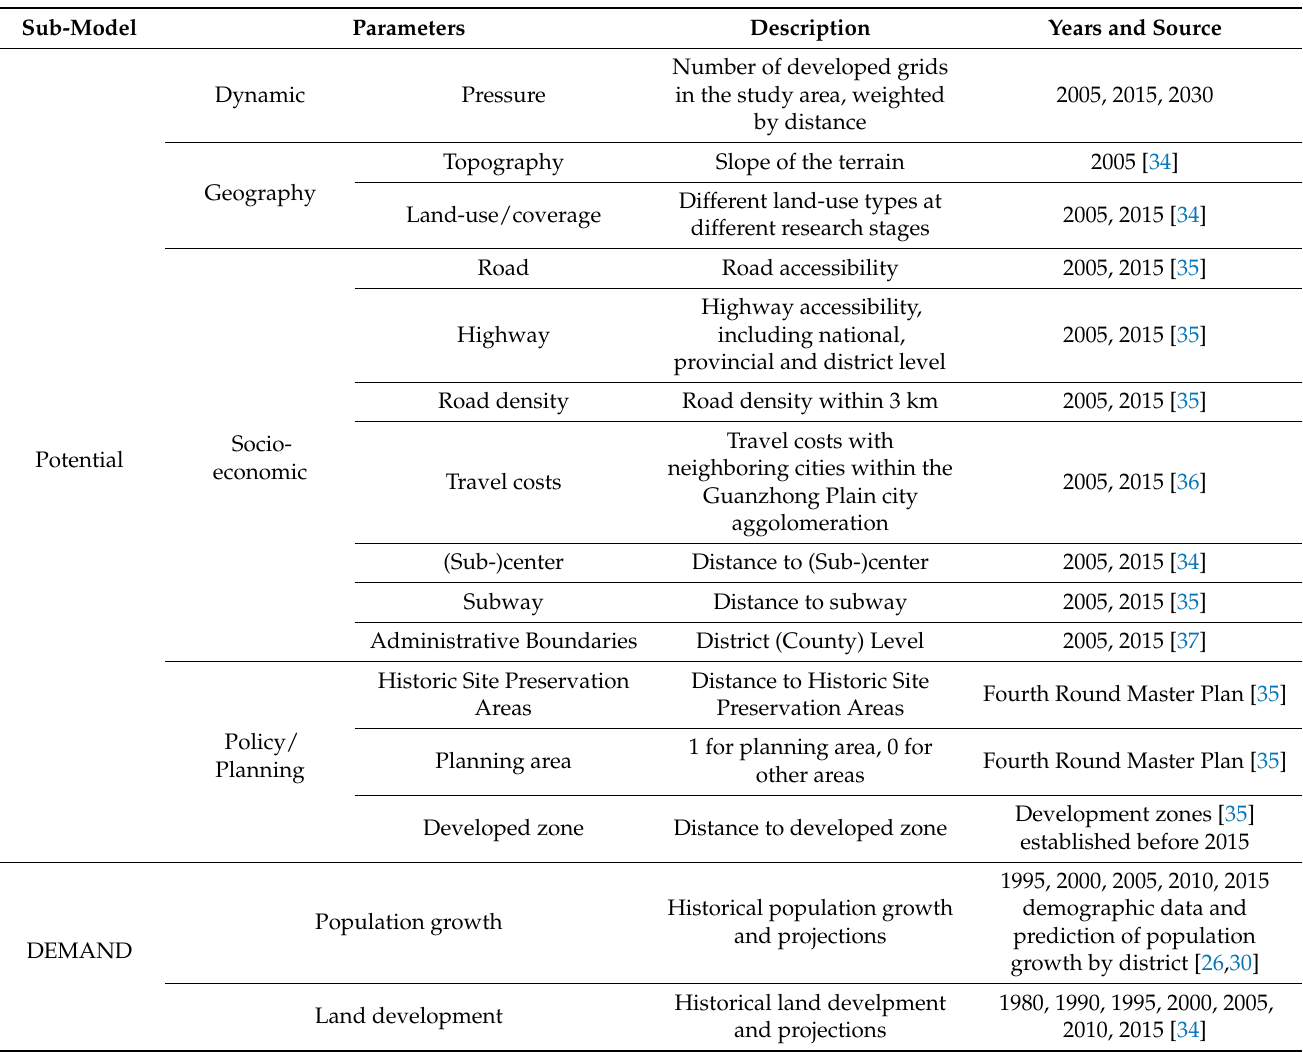
Table 1. Parameters for FUTURES model input associated with urban